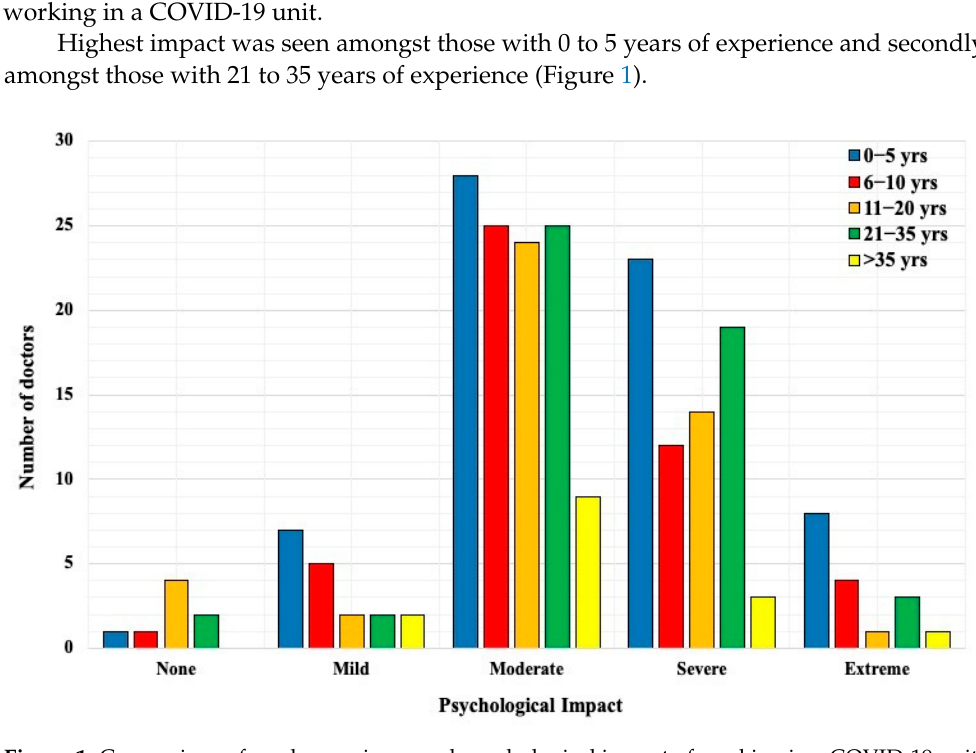
Figure 1. Comparison of work experience and psychological impact of working in a COVID-19 unit.